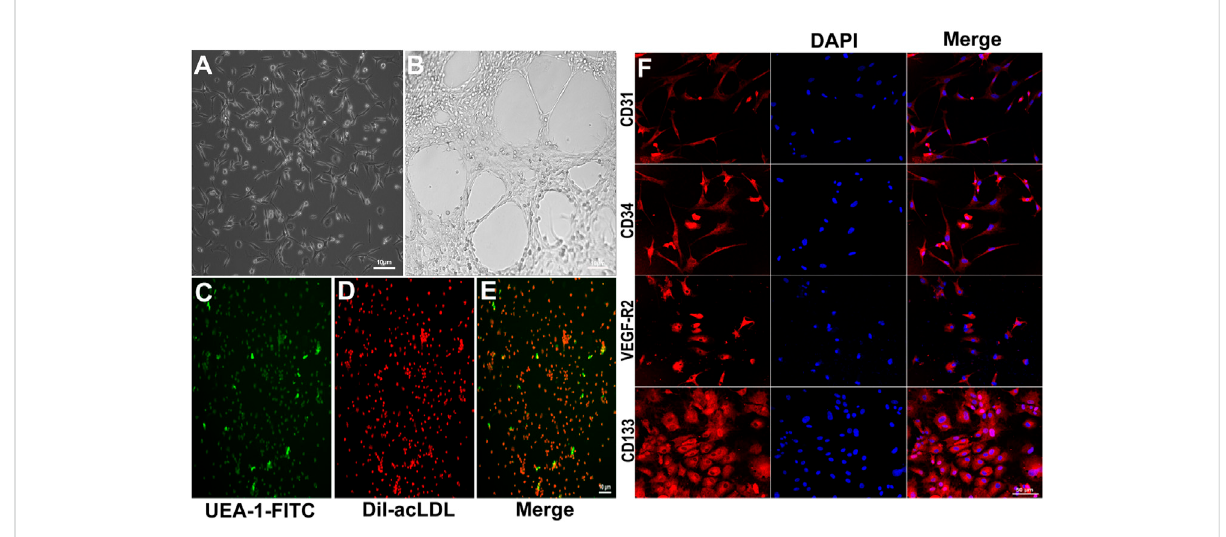
FIGURE 1 Characterization of cultured EPCs. (A) Typical morphological appearance (cluster-like morphology) of EPCs after 7 days of culture. (B) Tube formation in matrigel after 14 days culture.The cultured cells werestained with UEA-1-FITC ( C , green) and DiI-acLDL ( D , red);merged ( E , two-color overlay). (F) Representative immuno fl uorescence staining of endothelial cell markers CD31, CD34, VEGF-R2, and CD133 in red imaged using a laser confocal microscope (cell nuclei were counterstained with DAPI, shown in blue. “ Merge ” represents two-color